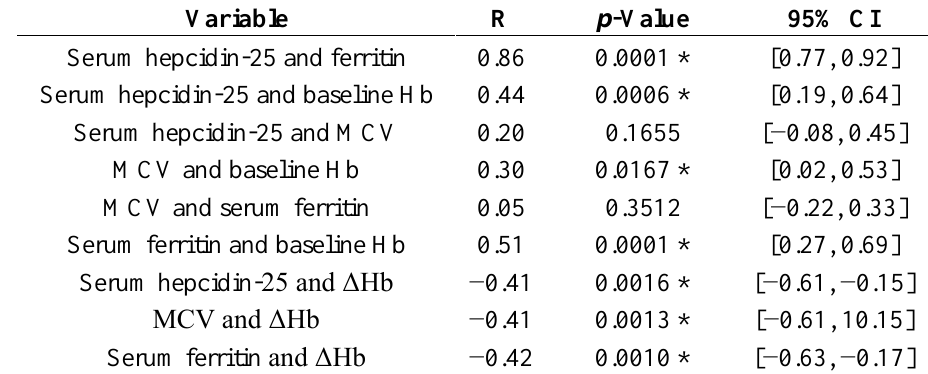
Table 3. Correlation between serum hepcidin-25, MCV, serum ferritin and baseline Hb before and ΔHb after